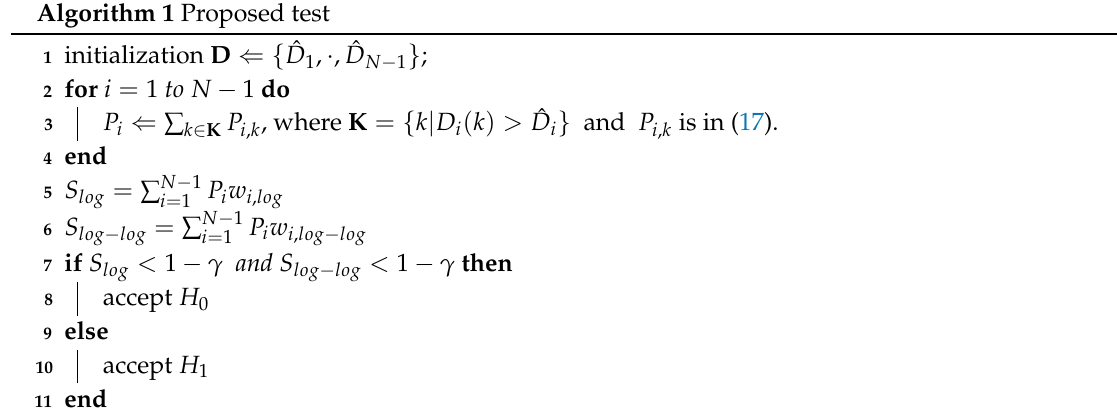
Algorithm 1 Proposed